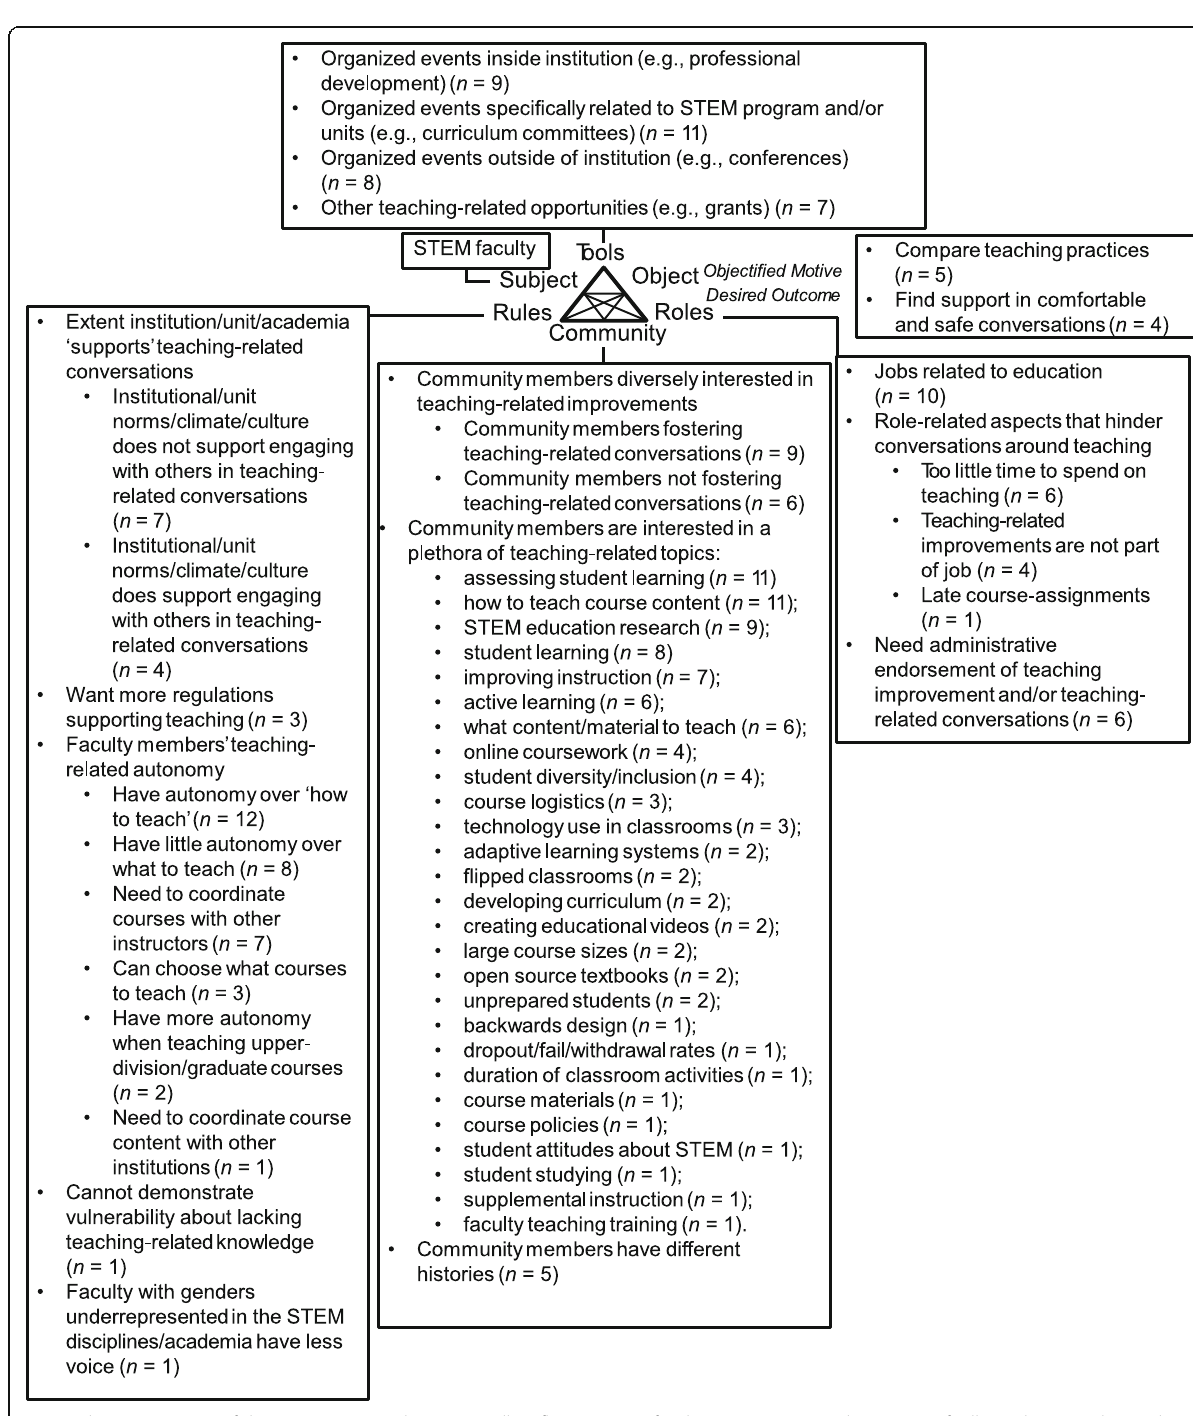
Fig. 2 The components of the activity system that potentially influence STEM faculty engagement in the activity of talking about teaching-related topics. The number of participants who contributed interview excerpts to each code is given by